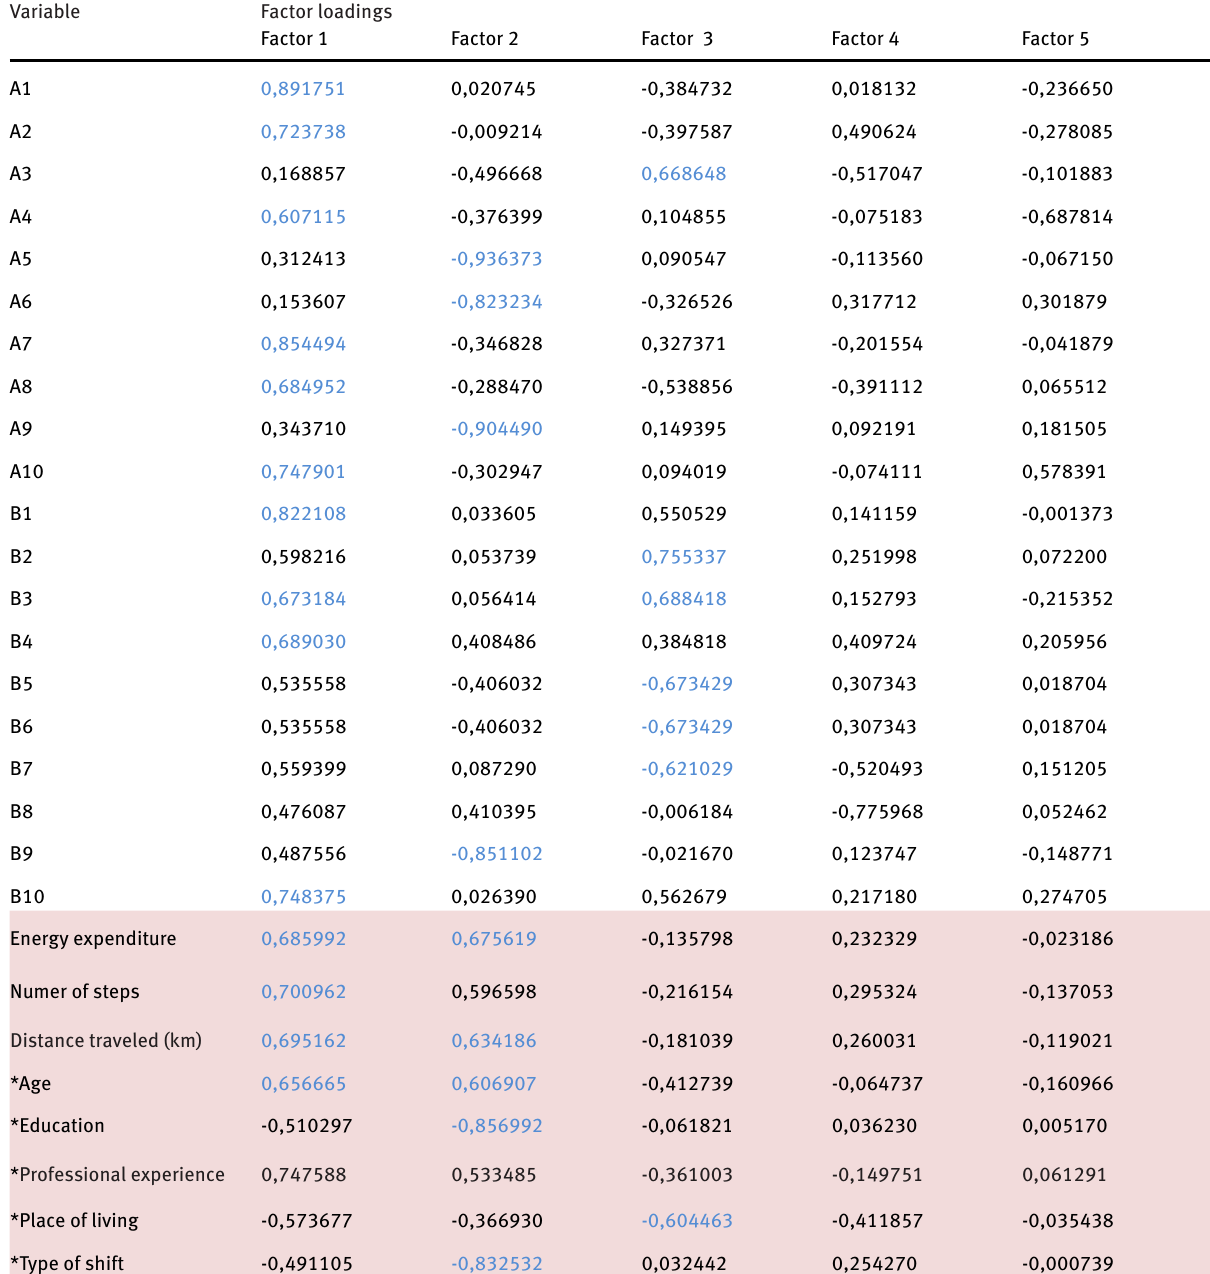
Table 4: Results of principal components factor analysis with varimax rotation.